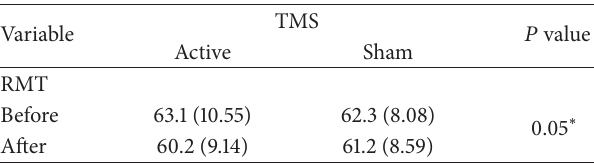
Table 3: Average means (SD) before and after rTMS for each group, and 𝑃 values for